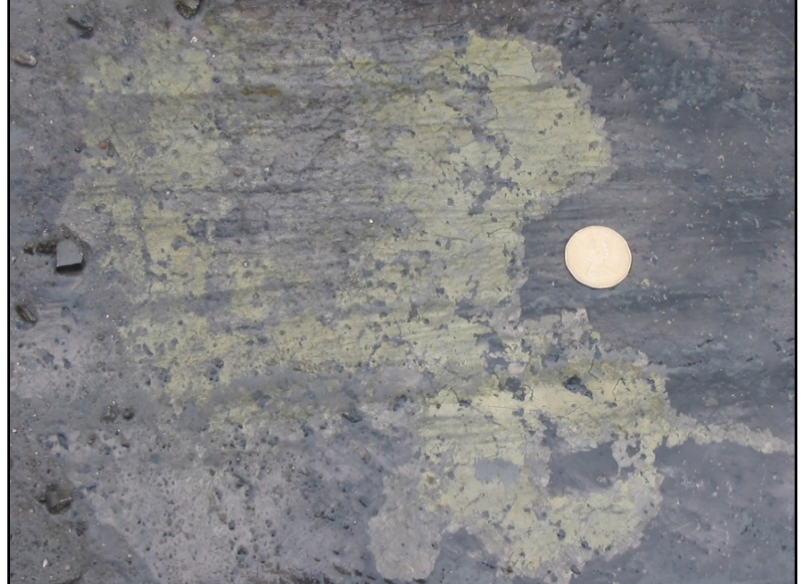
Figure 8. Surface of the Ovoid massive sulphide ore body, Voisey’s Bay, with glacial striae. The ore consists chalcopyrite (yellow), pentlandite (medium-grey) and pyrrhotite (dark grey) with magnetite (black) grains. A Canadian one dollar coin (“ loonie ”), 2.5 cm in diameter, is shown as a comparative